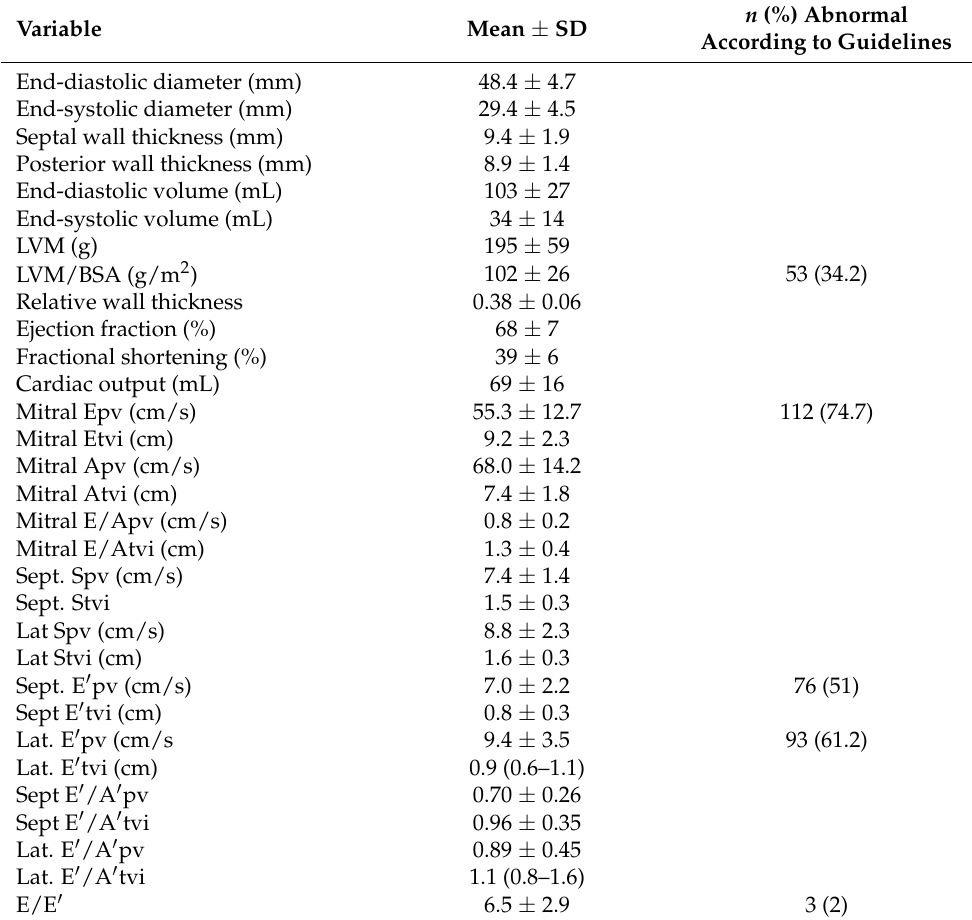
Table 2. Echo-based left ventricular structural and functional data in the total population ( n =